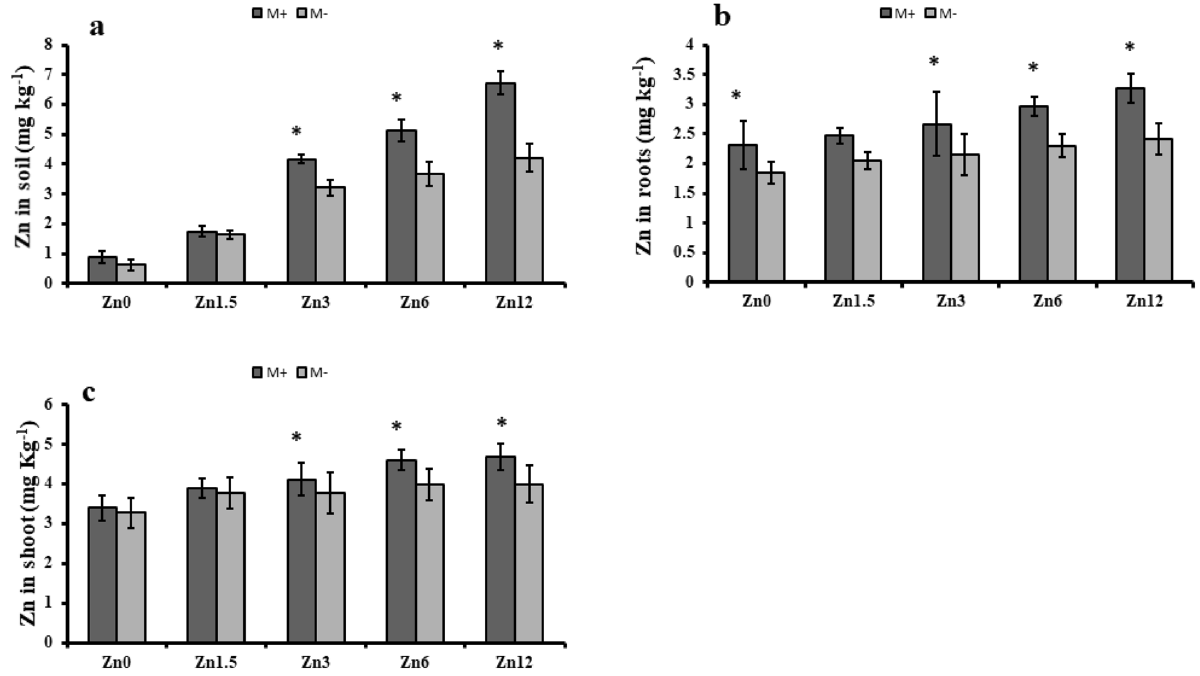
Figure 5. Effect of arbuscular mycorrhizal inoculation on zinc concentration of maize under zinc deficient soil conditions. ( a ) zinc concentration in soil (mg kg −1 ) ( b ) zinc concentration in root (mg kg −1 ) ( c ) zinc concentration in shoot (mg kg −1 ). Zn 0 (control), Zn 1.5 (1.5 mg kg -1 ), Zn 3 (3 mg kg -1 ), Zn 6 (6 mg kg -1 ), Zn 12 (12 mg kg -1 ), inoculated with AMF (M + grey), un-inoculated (M- white). Error bars represent standard error and asterisk (*) shows significant difference ( p ≤ 0.05) among treatments (Zn × AMF interaction).